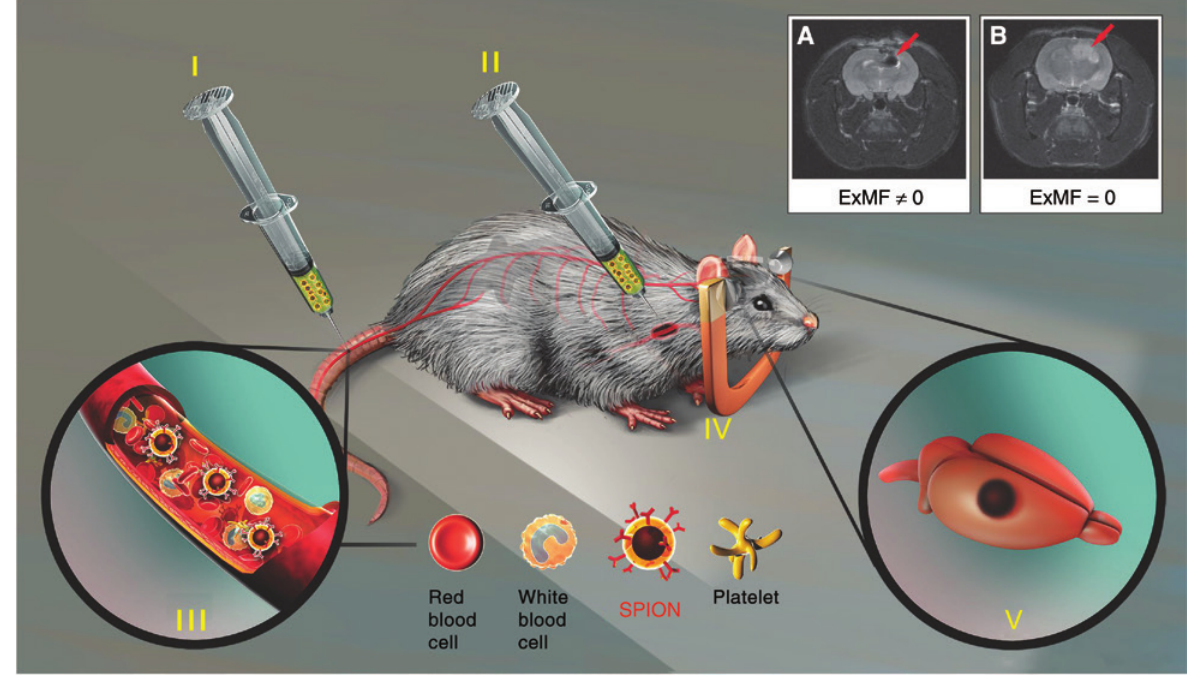
Figure 1: Representation of in vivo magnetic targeting using superparamagnetic iron oxide nanoparticles (SPIONs). The process begins with the SPIONs being administered caudally (I) or by carotid artery (II) and being transported by the blood flow (III). An external magnetic field (ExMF) is applied to target the tumor with SPION (IV), which are concentrated in the tumor tissue (V). MRI showing SPION accumulation (arrow) in tumor with (A) and without (B) ExMF. The illustrations are not drawn to